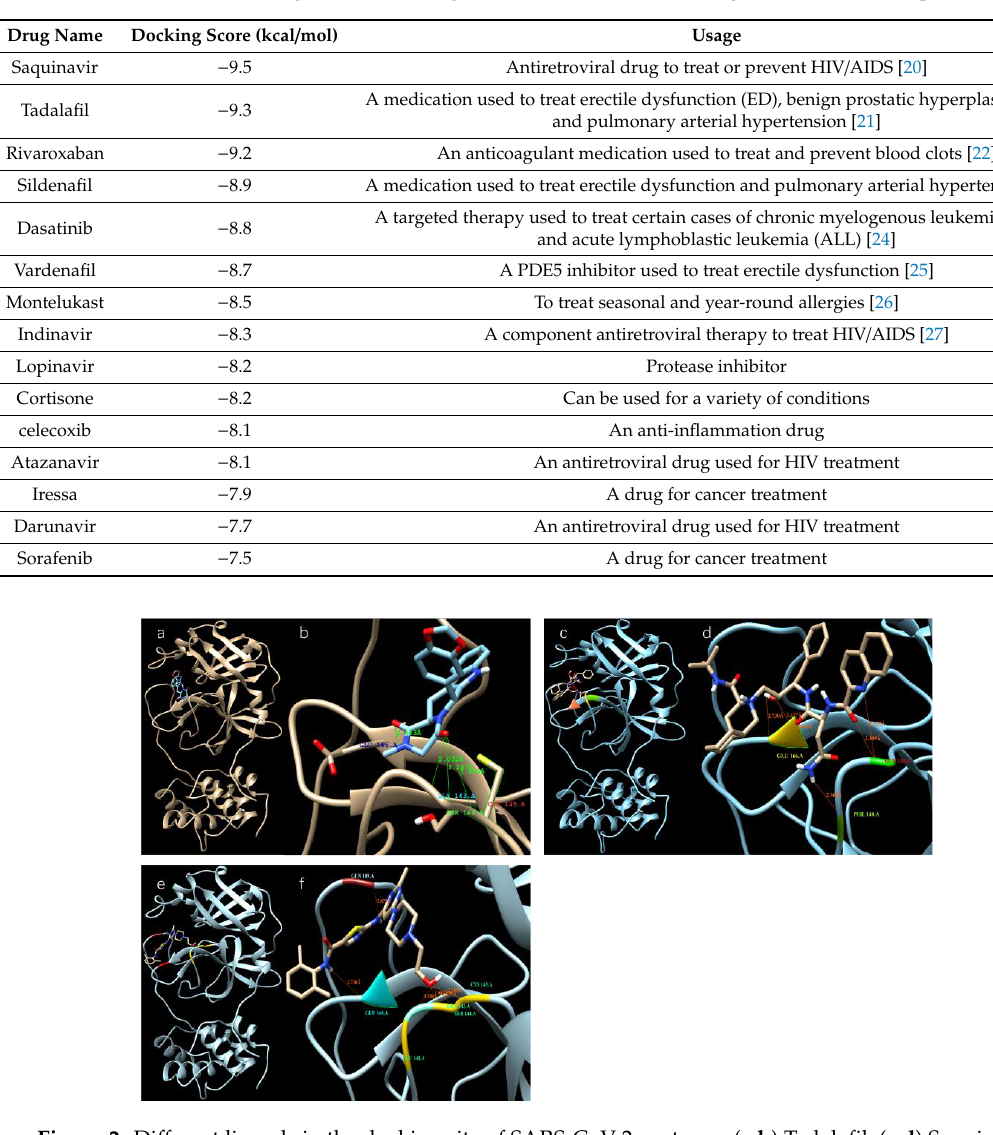
Figure 2. Different ligands in the docking site of SARS-CoV-2 protease. ( a ), ( b ) Tadalafil; ( c ), ( d ) Figure 2. Di ff erent ligands in the docking site of SARS-CoV-2 protease. ( a , b ) Tadalafil; ( c , d ) Saquinavir; Saquinavir; ( e ), ( f ) Dasatinib. ( e , f )